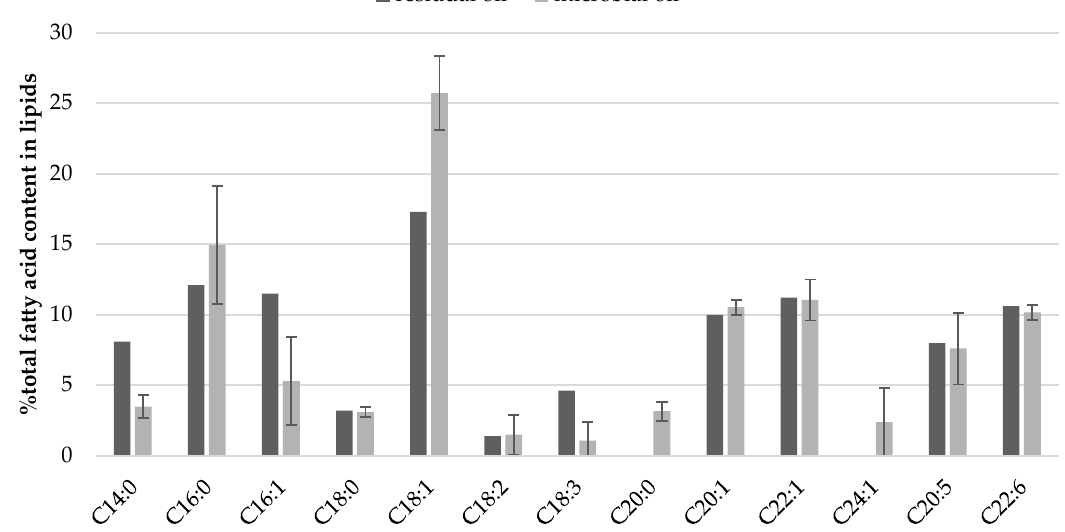
Figure 3. Parallel of fatty acid content in cellular lipids synthesized in MF5-O 2 medium and in residual oil in supernatant at the end of yeast culture in stationary growth phase.